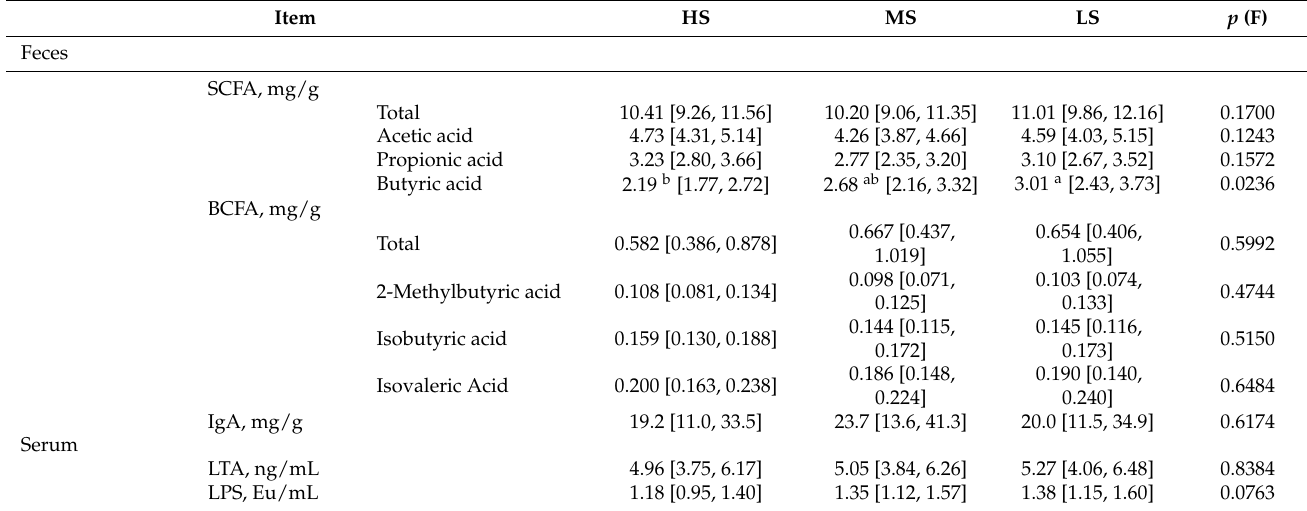
Table 3. Estimated mean concentration (and [95% confidence interval]) of fecal short-chain fatty acids (SCFA), branched- chain fatty acids (BCFA) and immunoglobulin a, as well as serum gram-positive and gram-negative bacterial cell wall constituents lipoteichoic acid (LTA) and lipopolysaccharide (LPS), respectively, of fasting dogs fed dietary treatments s produced at high, medium and low shear (HS, MS and LS,